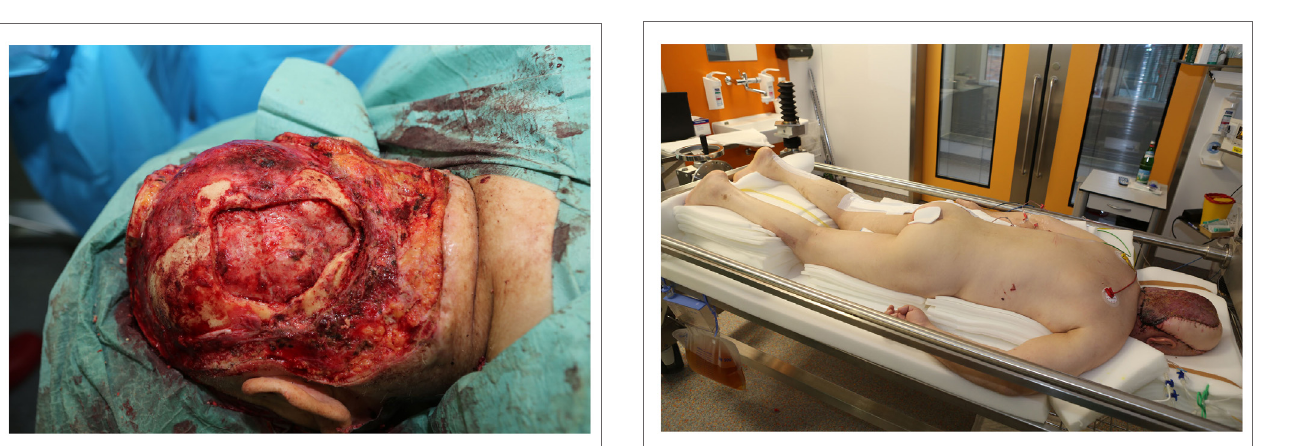
FiGURe 12 | intraoperative view after resection of the scalp and the infiltrated calvarium .